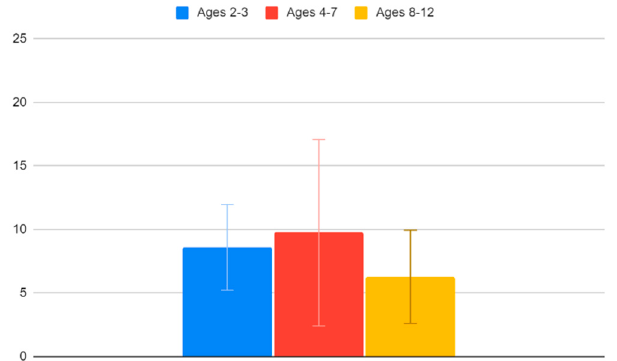
Figure 9. VACS values and